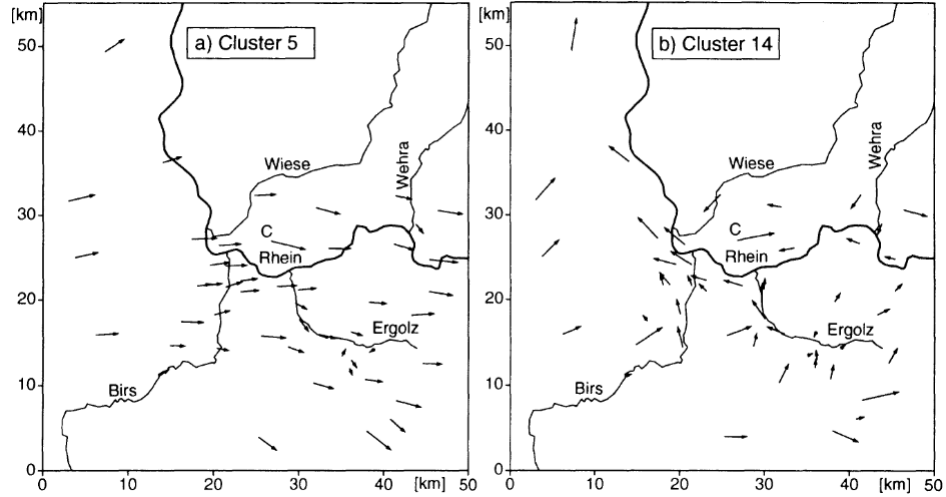
Figure 29. Cluster averages of normalized wind vectors at all measurement sites for ( a ) cluster 5 and ( b ) cluster 14. “C” labels the station on the TV tower at St. Chrischona [23].